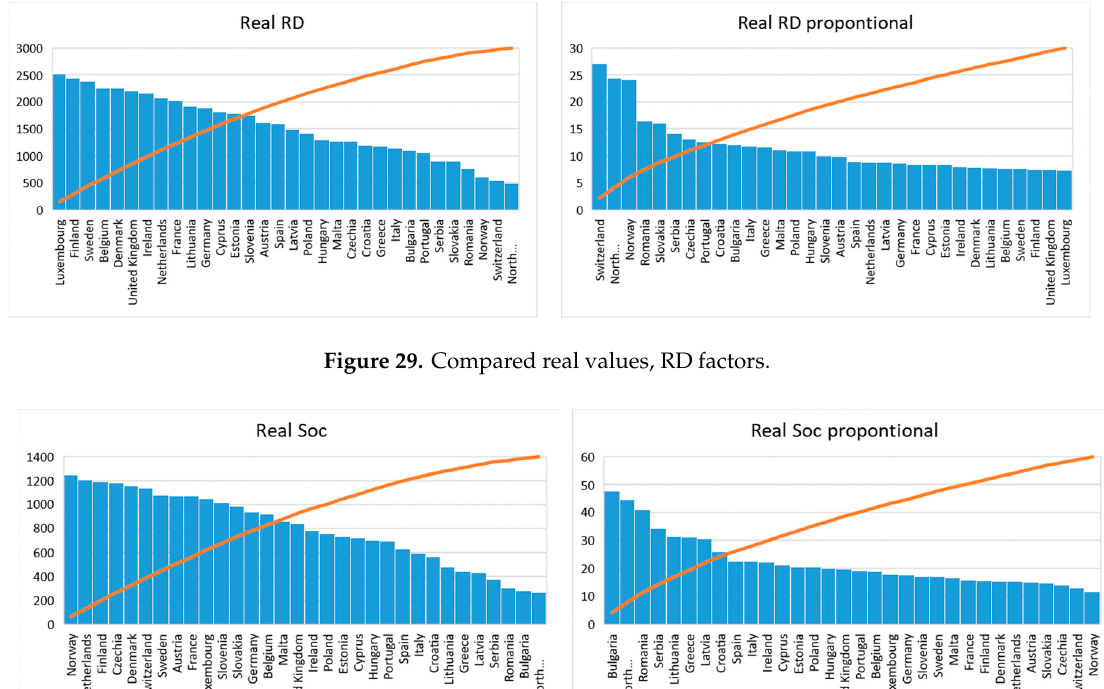
Figure 28. Compared real values, EM factors.